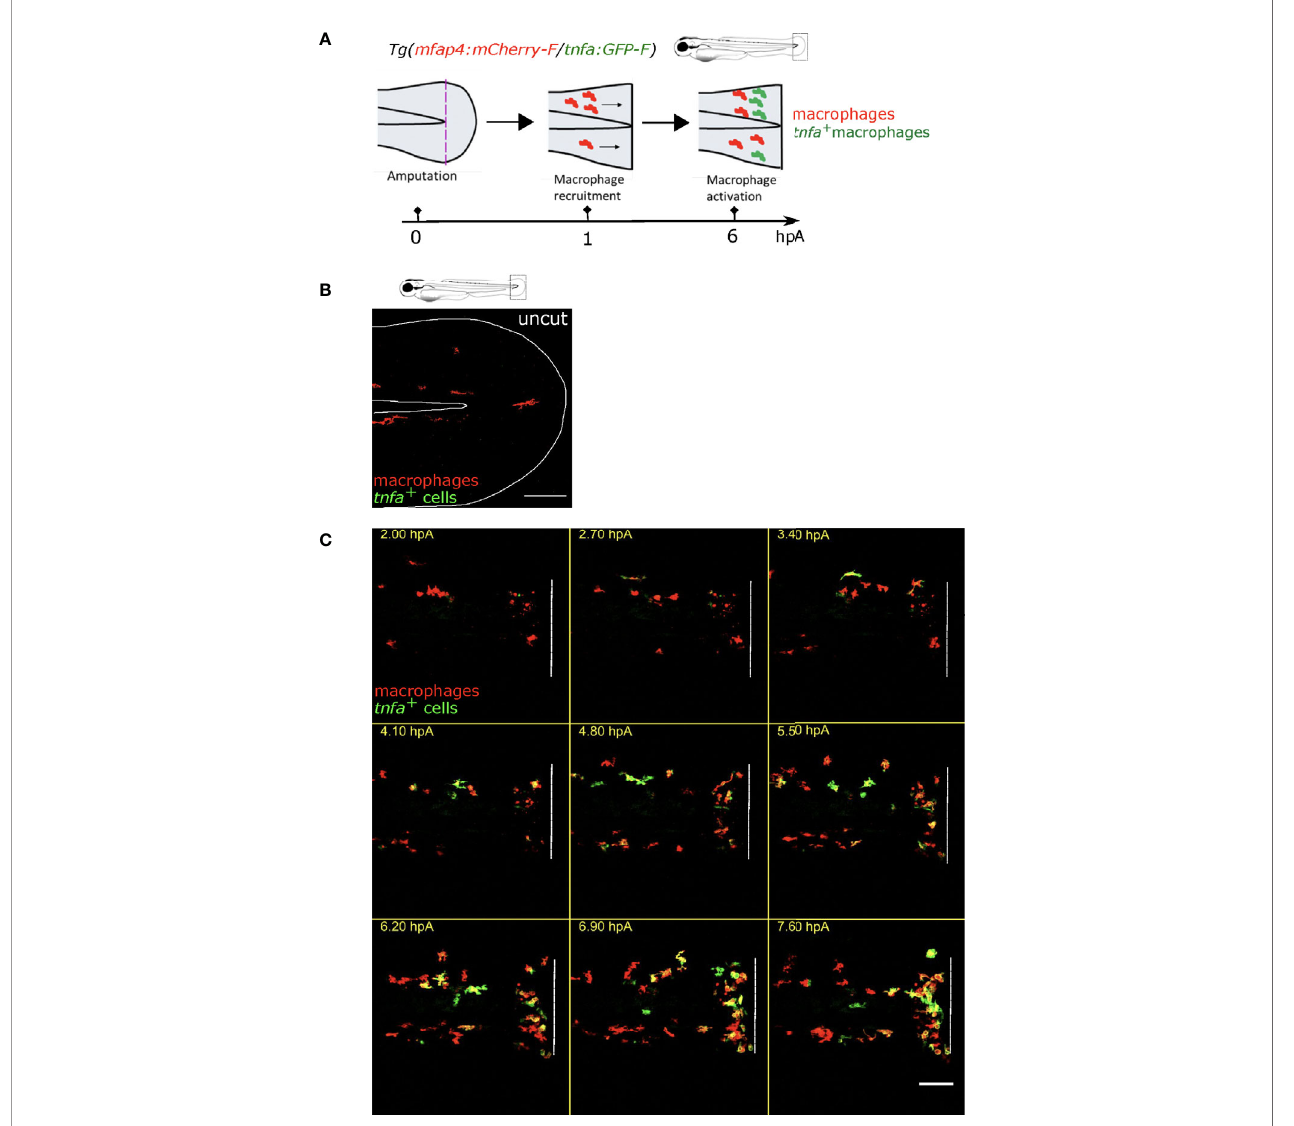
FIGURE 1 | Tg(mfap4:mCherry-F/tnfa:GFP-F) reporter line allows imaging of macrophage M1-like activation at the wound in response to fi n fold injury. (A) The caudal fi n fold of Tg(mfap4:mCherry-F/tnfa:GFP-F) larvae were amputated at 3 dpf. Schedule of the recruitment and M1-like activation of macrophages at the wound after the fi n fold injury. (B) Representative image of uncut zebra fi sh fi n fold. Maximum projection of the overlaid fl uorescence of mCherry-F (macrophages) and GFP-F (tnfa+ cells). The white line outlines the fi n fold and the notochord. Scale bar: 100 m m. (C) Macrophage movements and activation states were imaged by confocal microscopy from 1.5 to 9.5 hours post amputation (hpA) using the tg(mfap4:mCherry-F/tnfa:GFP-F) line. Tail images are representative maximum projections of the overlaid fl uorescences of mCherry-F (macrophages) and GFP-F ( tnfa + cells), showing M1-like activation of recruited macrophages at the wound, starting from 3 hpA and increasing up to 7.6 hpA. Dashed line indicates the wound margin. Scale bar: 100 m